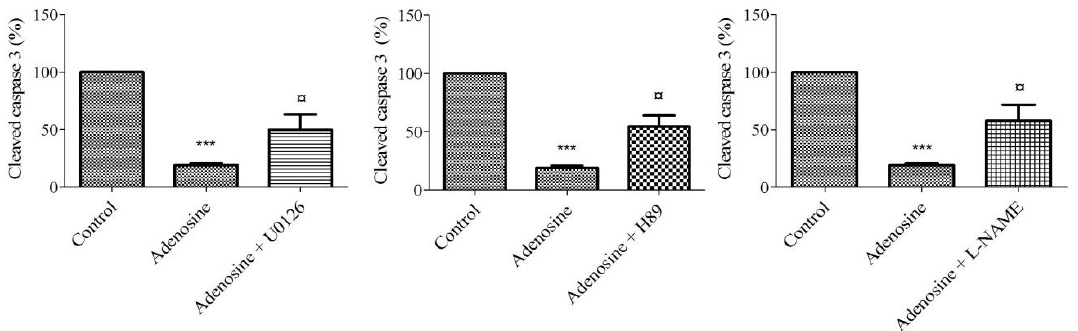
Figure 5. Signaling pathways involved in the anti-apoptotic effect of adenosine. HUVECs were treated with different antagonists: 10 µ M U0126 (MEK/ERK1/2), 20 µ M H89 (PKA), and 10 µ M L-NAME (NOS). Results are expressed as means ± sem ( n = 6/group) of relative caspase 3 expression (%) in HUVECs after 2 h of hypoxia. ¤ p < 0.05, compared to 10 µM adenosine group. *** p < 0.001 compared to the control.